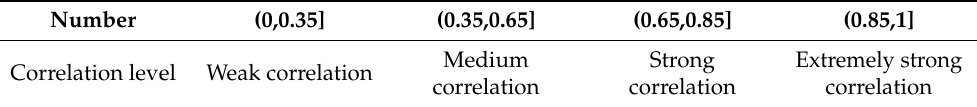
Table 2. Classification Criteria for the Degree of Correlation and Coupling Effect